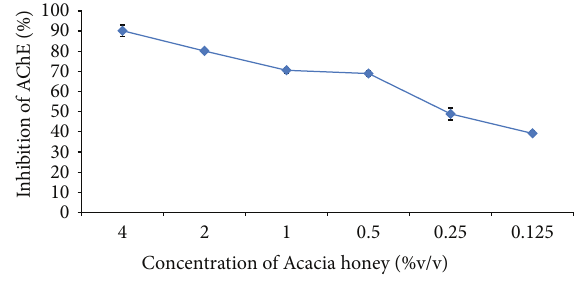
Figure 2: The effect of Acacia honey on the activity of acetyl- cholinesterase in vitro . Values are presented as mean ±